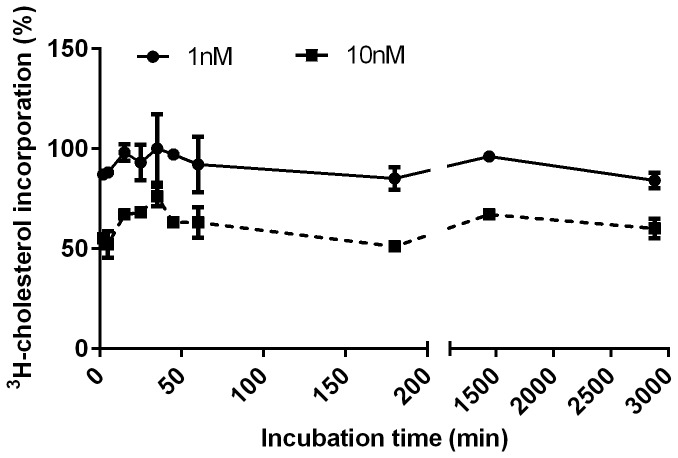
Time-dependent 3H-cholesterol incorporation to mammary gland (MG) enriched plasma membrane vesicles (EPM).The figure illustrates representative kinetics of incorporation of 1nM (●) and 10nM (■) 3H-cholesterol into EPM (100µg) isolated from lactating MG tissues. Data represent the means of three independent experiments performed in triplicates. The incorporation reaction was incubated at 37°C using glass tubes coated with bovine serum albumin. The radioactivity of the filter was measured using a β-counter. No difference was found between lactating and non-lactating MG.